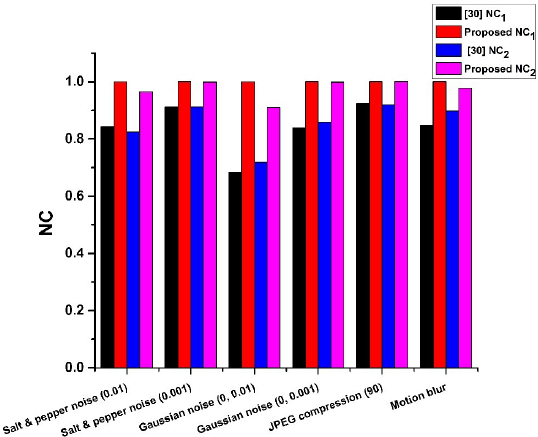
Figure 8: NC Values Comparison among Proposed Scheme and Scheme Reported in